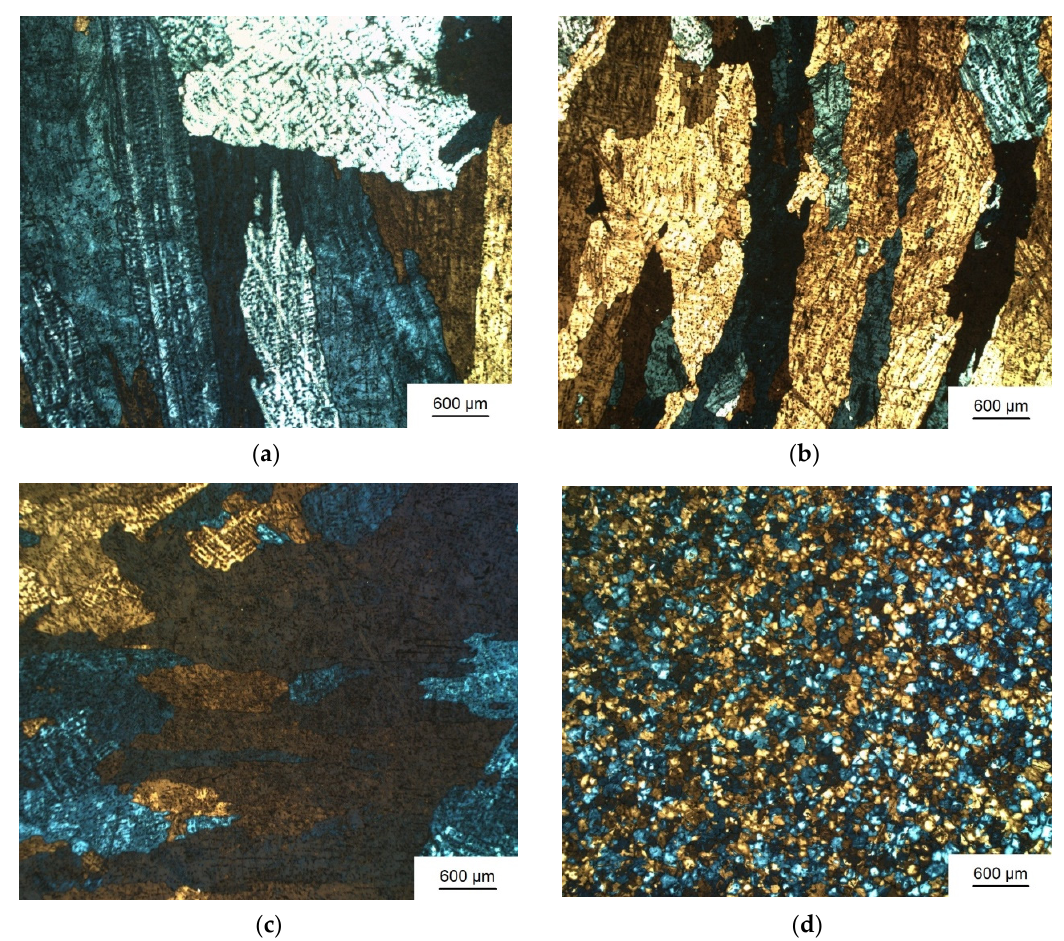
Figure 1. Grain structure after casting ( a ) Al 0.3 Mg 1 Si, ( b ) Al 0.3 Mg 1 Si 0.3 Sc, ( c ) Al 0.3 Mg 1 Si 0.15 Zr, ( d ) Al 0.3 Mg 1 Si 0.3 Sc 0.15 Zr.